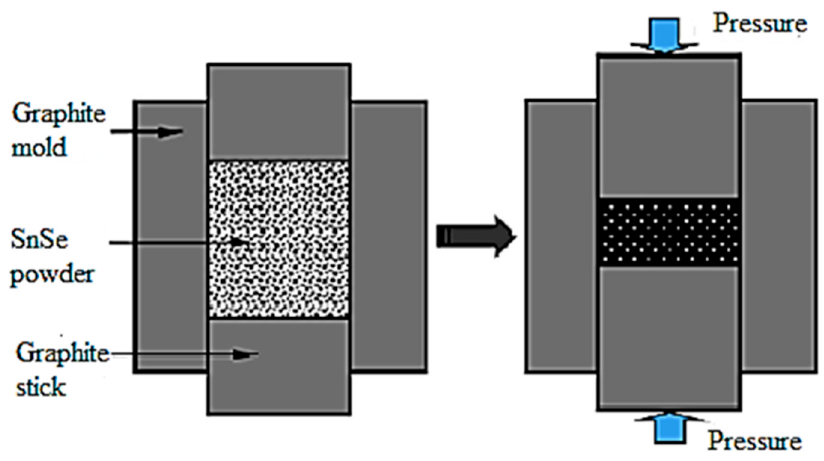
Figure 5. Schematic diagram of SnSe polycrystalline sintering by hot-pressing technique. Reprinted with permission from [96].